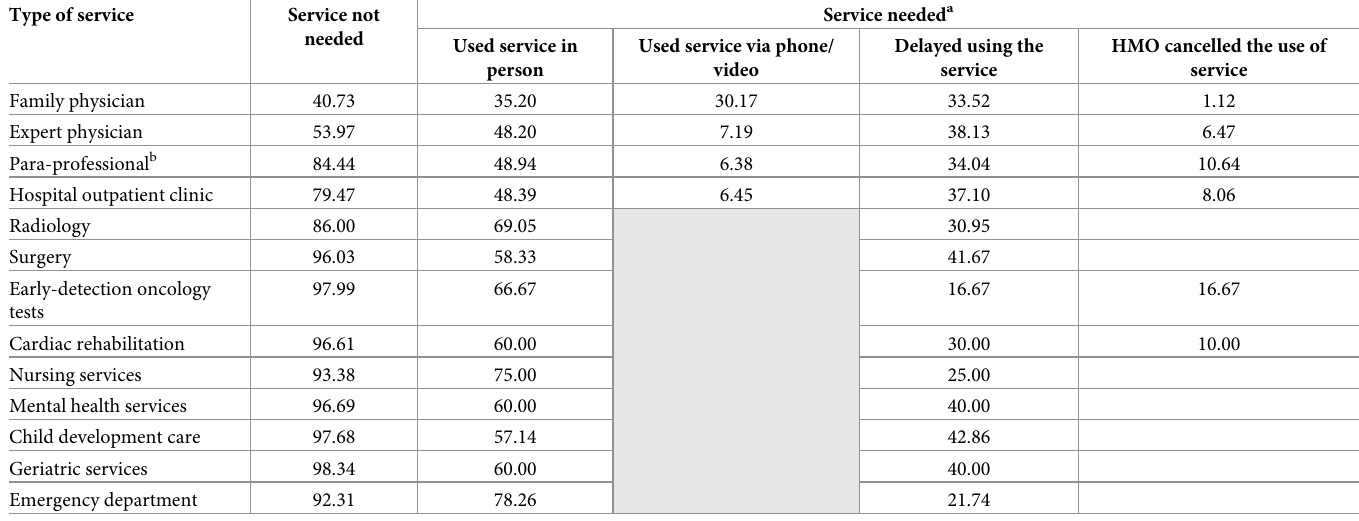
Table 2. Need and use of healthcare services in Israel’s basket of services (%) (n = 302).